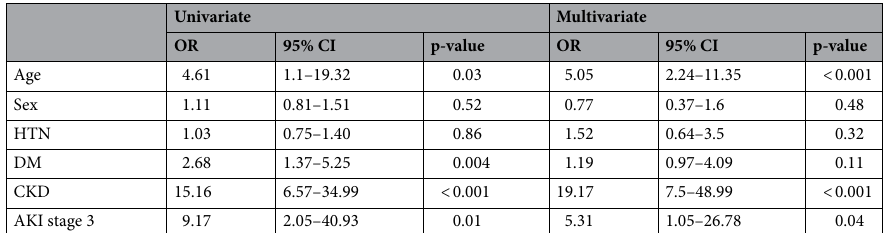
Table 5. Logistic regression analysis of factors associated with ESKD progression (non-malignant obstruction). Multiple logistic regression analysis was conducted after adjustment for sex, age over 65 years, hypertension, diabetes mellitus, ischemic heart disease, underlying liver disease, chronic kidney disease (eGFR ≤ 60 ml/min/1.73 m 2 ), and AKI stage. AKI acute kidney injury, HTN hypertension, DM diabetes mellitus, CKD chronic kidney disease.